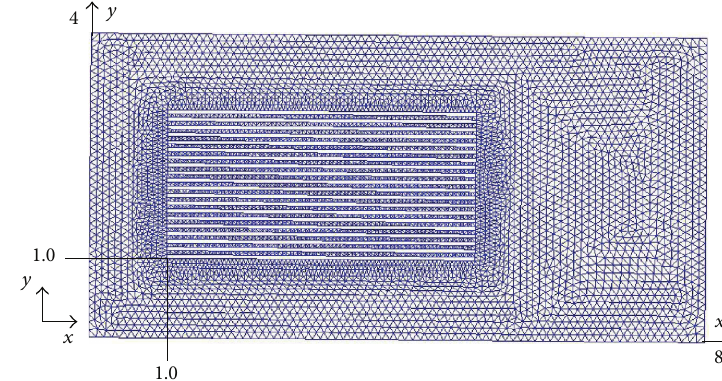
Figure 7: Mesh of a PEC rectangular plate with thin slots. The dimension of the plate is 8 𝜆 by 4𝜆 and that of each slot is 4 𝜆 by 0.05 𝜆 .